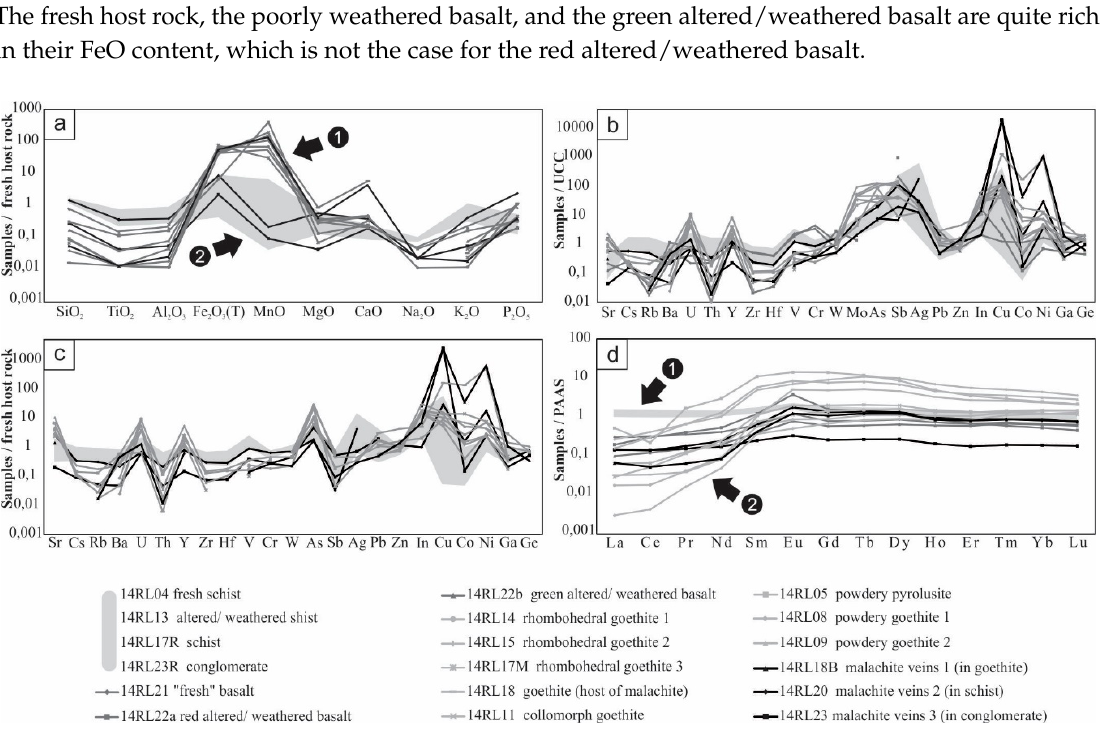
Figure 6. Geochemical data: ( a ) major elements patterns, with values normalized to the host rock (fresh schist). A distinct divergence is observed between the copper veins in schists and conglomerates (group 2), and the others (group 1); ( b ) trace elements patterns, with values normalized to the UCC (Upper Continental Crust) [18]; ( c ) trace elements patterns, with values normalized to the host rock (fresh schist); ( d ) REE patterns, with values normalized to the PAAS [18]. A distinction is observed between the host rocks (no REE fractionation; group 1), and the mineralized samples (REE fractionation; group 2). The shaded areas indicate the major elements ( a ), minor elements ( b , c ), and REE ( d ) contents of the host rocks (schists and conglomerate).